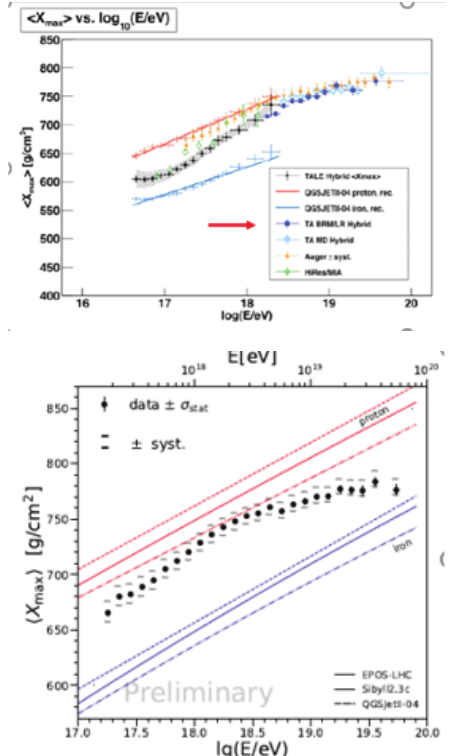
Fig.1 . Recent measurements of the depth of shower maximum from the Telescope Array Collaboration (upper plot) [4], and from the Auger Collaboration (lower plot figure) [5]. Note that different models have been used by the Collaborations for the comparisons of data with models. The QGSJet II-04 model gives a poor description of some features of data from the Auger Observatory. For the Auger data, the Elongation Rate above 3 EeV is 26 ± 2.5 g cm -2